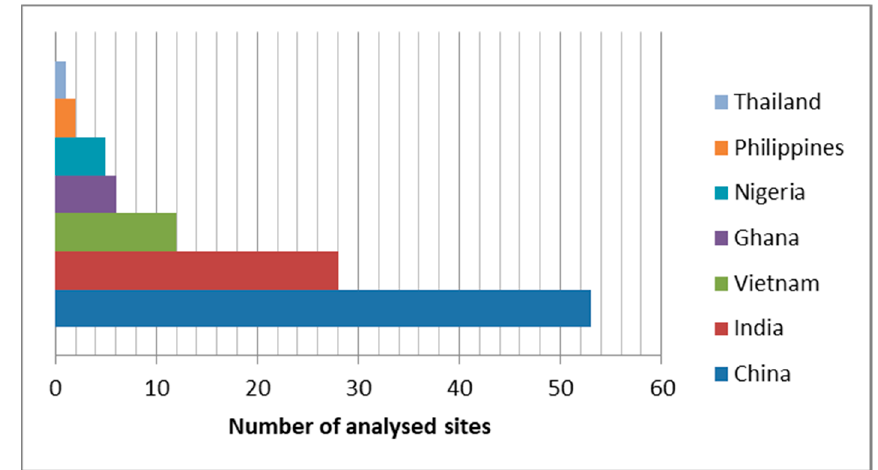
Figure 1. Number of sites analyzed in the selected countries.